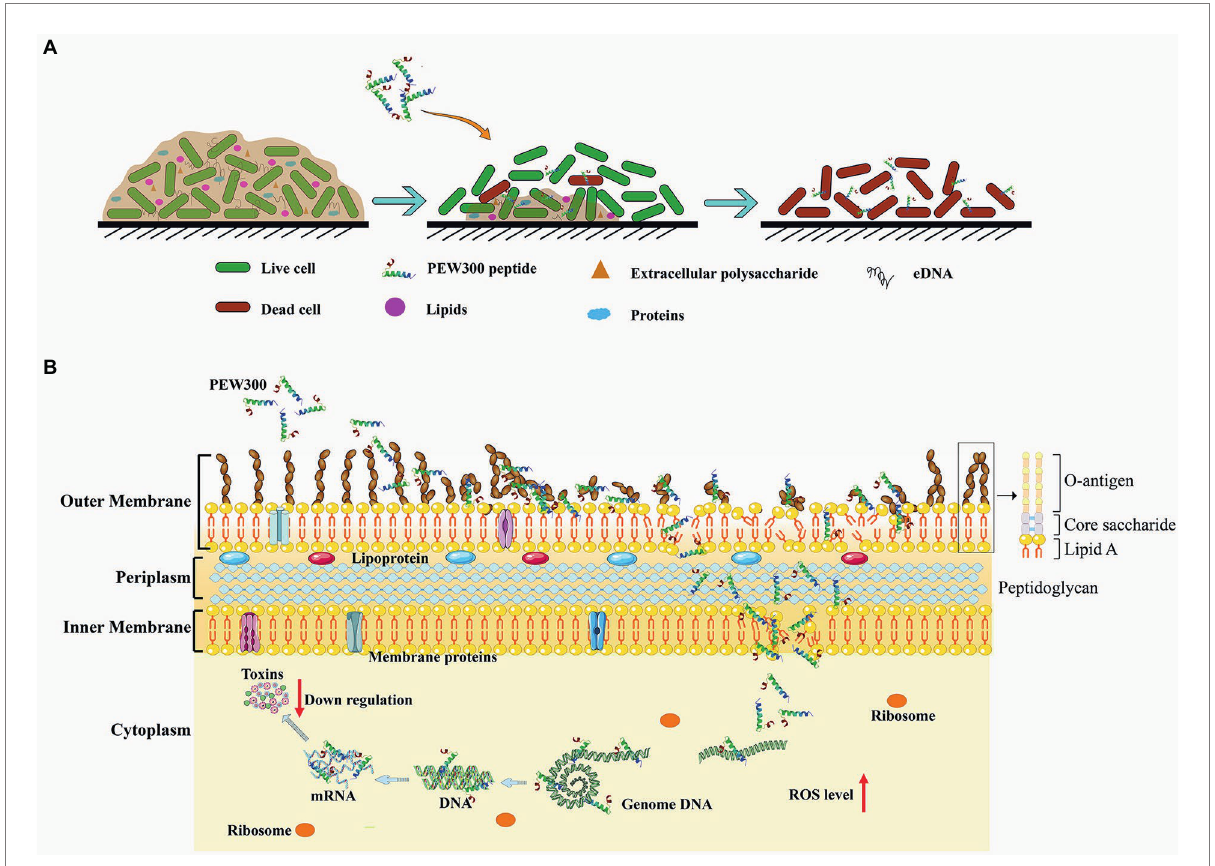
FIGURE 10 Schematic illustration of the (A) antibiofilm pathway and (B) the multiple actions of PEW300 against Pseudomonas aeruginosa